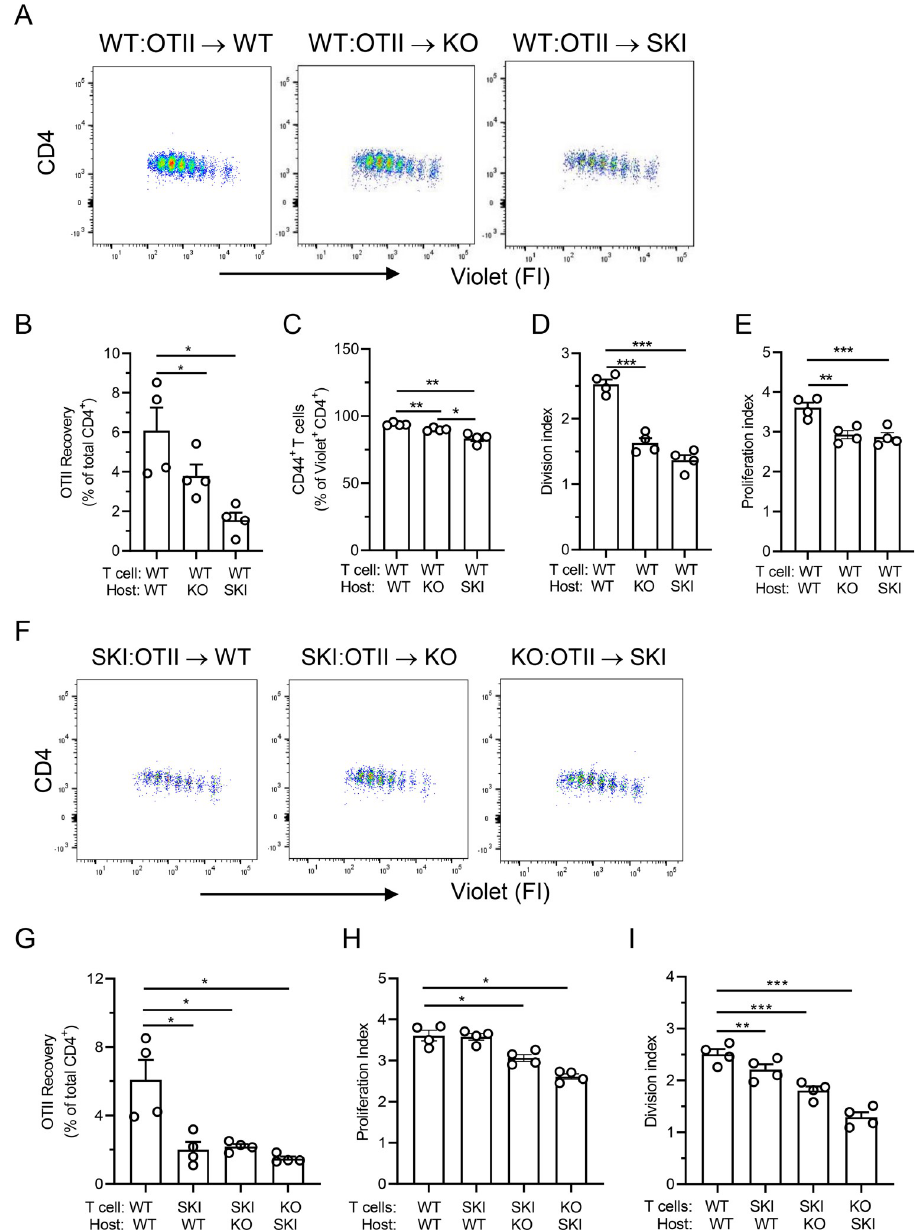
Fig 2. CD47 deficiency or loss of SIRP α signaling in recipient mice results in severe reduction in CD4 + T cell expansion in vivo. (A) Proliferation of adoptively transferred na ï ve dye labeled CD4 + OTII T cells recovered from WT, Cd47 KO or SKI recipient mice. Means ± SEM from 3–4 animals per group from 2 separate experiments. (B-E) CD4 + OTII T cell expansion in 72 h, % CD44 hi activated T cells, and proliferation and division indexes relative to WT mice. Means ± SEM from 4 mice per group, results are representative of 2 independent experiments. � p < 0.05, �� p < 0.01, ��� p < 0.001 versus WT mice by one-way ANOVA with Tukey test. (F) Proliferation of adoptively transferred na ï ve dye-labeled SKI or Cd47 KO CD4 + OTII T cells recovered from WT, Cd47 KO or SKI recipient mice. Means ± SEM from 4 animals per group. (G-I) CD4 + OTII T cell expansion in 72 h, % CD44 hi activated T cells, and proliferation and division indexes relative to WT mice. Means ± SEM from 4 mice per